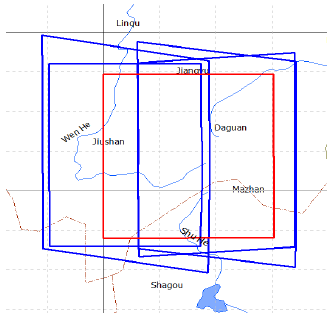
Figure 1. Coverage the test area and images